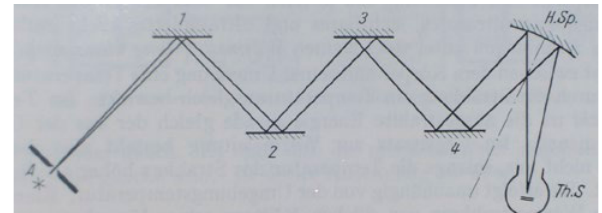
Figure 5. The residual radiation method according to Heinrich